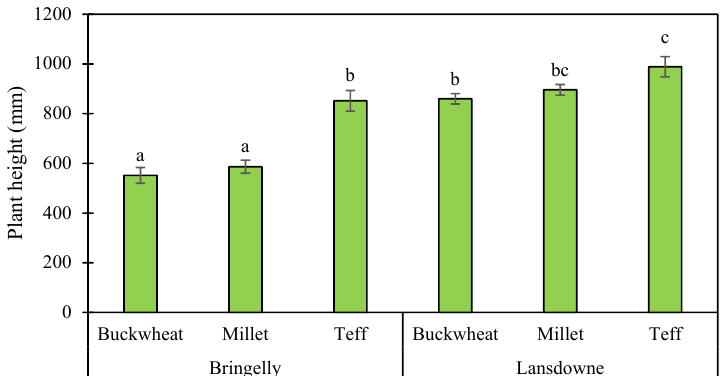
Figure 3. Average crop heights at Bringelly and Lansdowne. Error bars show standard errors of the mean of four replicates. Different letters show significant differences ( p < 0.05) between cover crop treatments at each site.